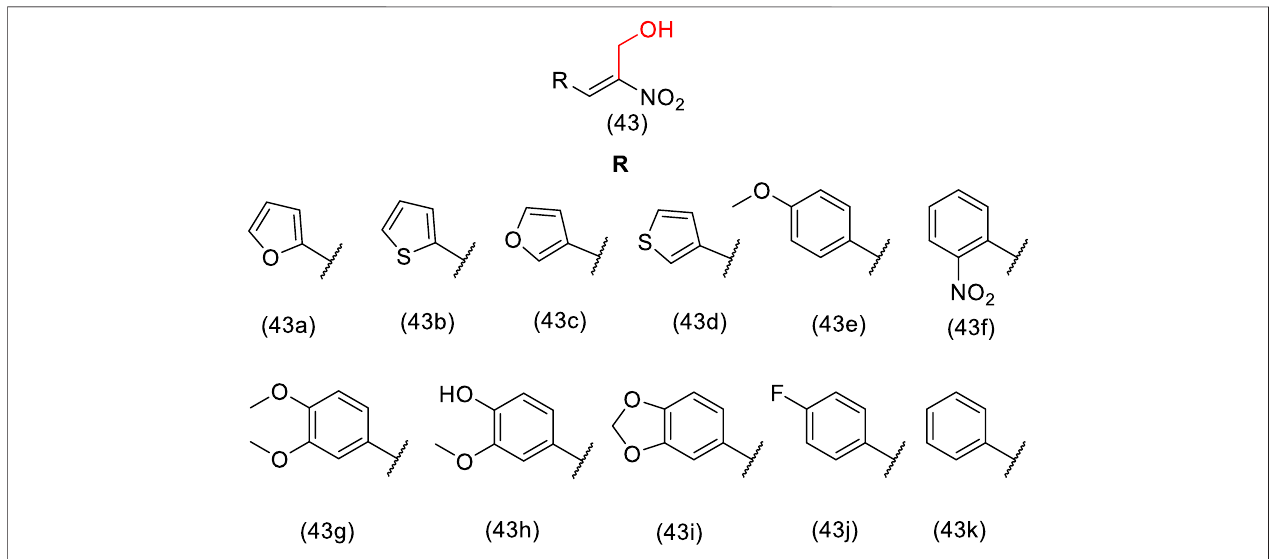
FIGURE 2 | Hydroxymethyl nitroalkene compounds ( 43a - k ) active in depolymerization of microtubules.